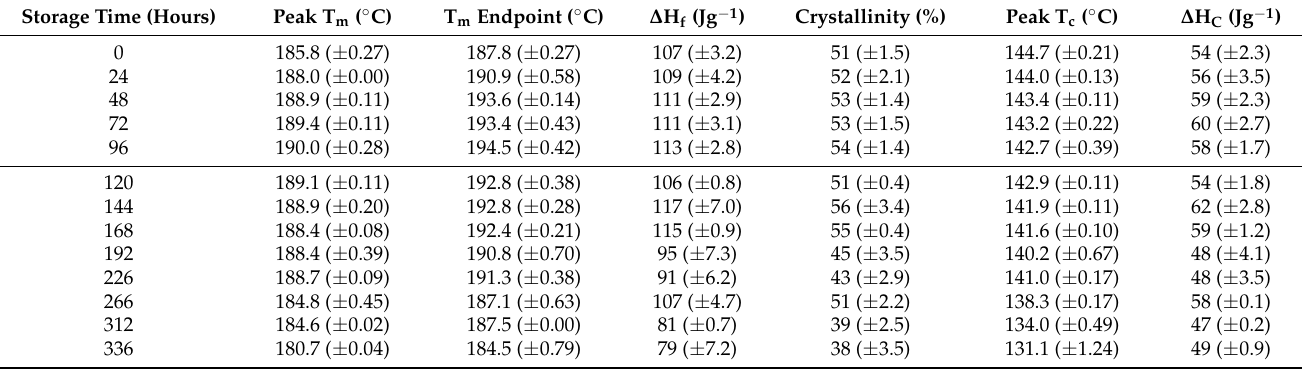
Table A1. Experimental data at all storage times for PA-12 powder, whereby the values shown are taken as an average from 3